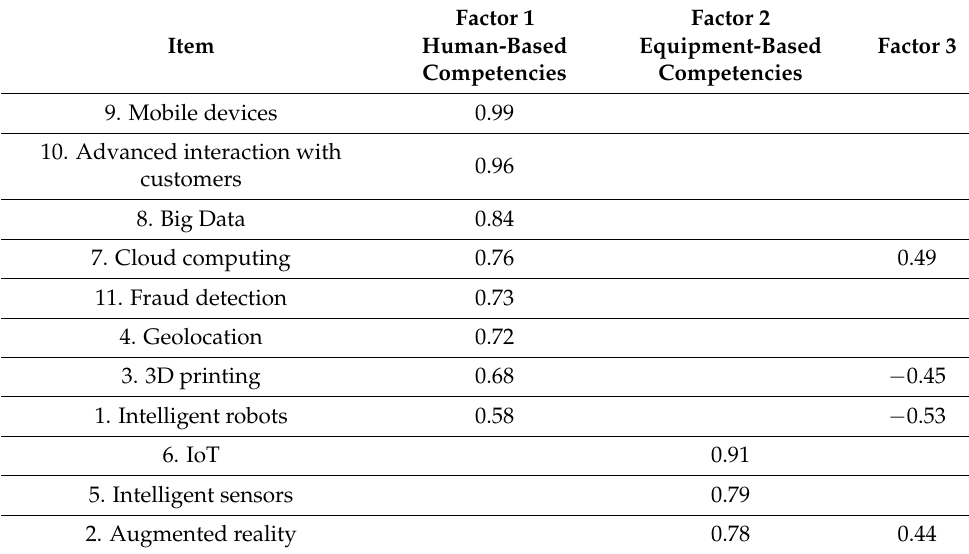
Table 4. Pattern matrix acquired in the principal component analysis regarding technological compe- tencies.